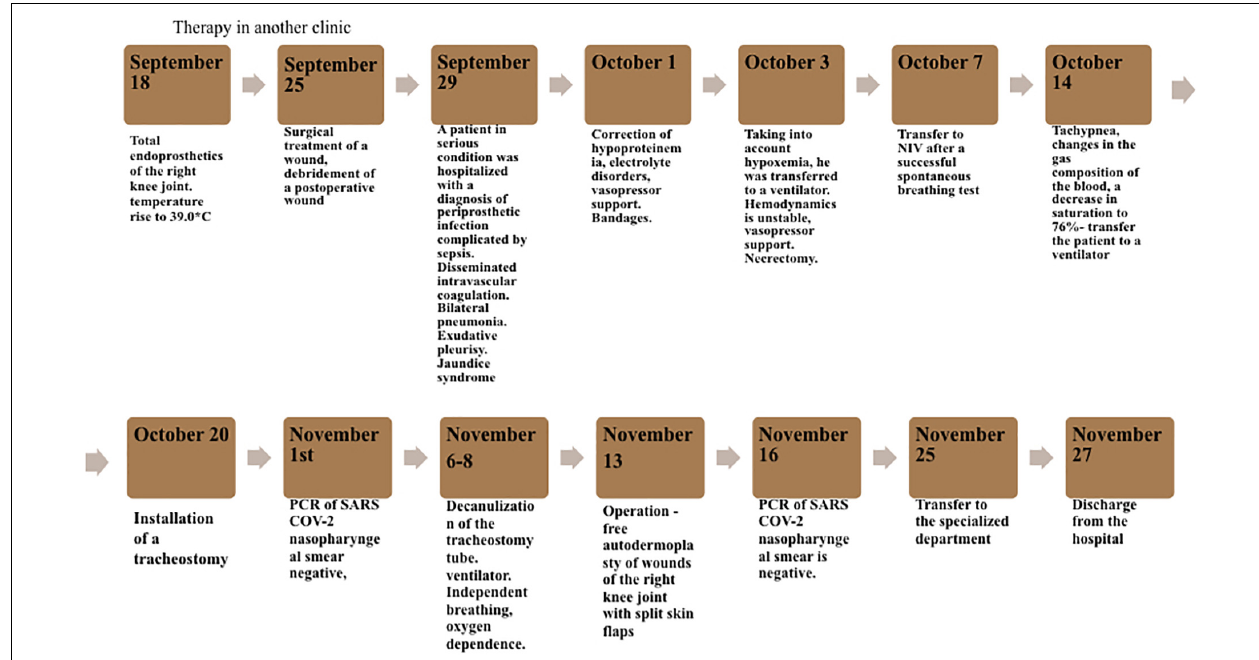
FIGURE 1 | Chronology of the patient’s medical history from the moment of surgery at the private clinic to discharge from the hospital.